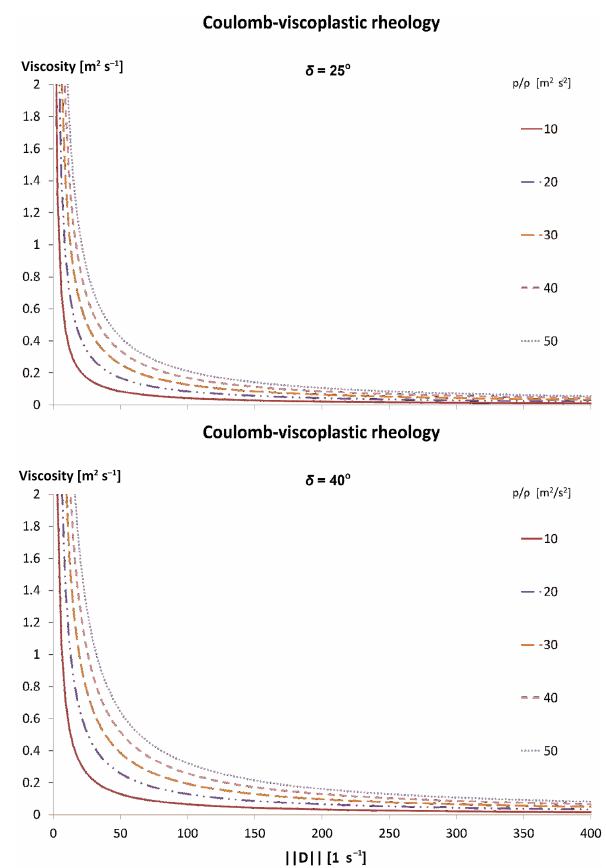
Figure 4. Dependency of the kinematic gravel phase viscosity (for friction angle δ = 25 ◦ and 40 ◦ ) on the norm of the strain rate tensor || D || at different levels of pressure normalized by density, for m y =